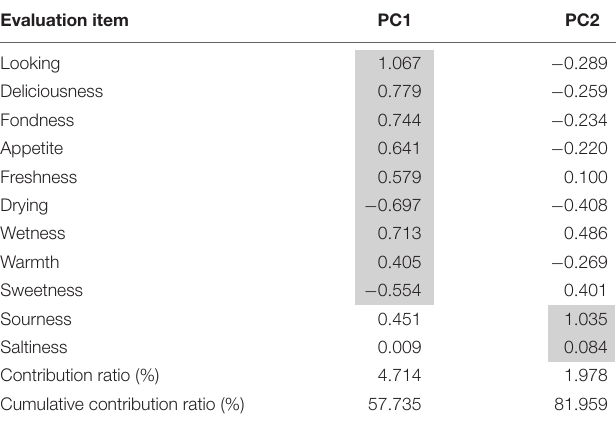
TABLE 6 | Result of principal component analysis: principal component loadings of all eleven adjective pairs. Evaluation item